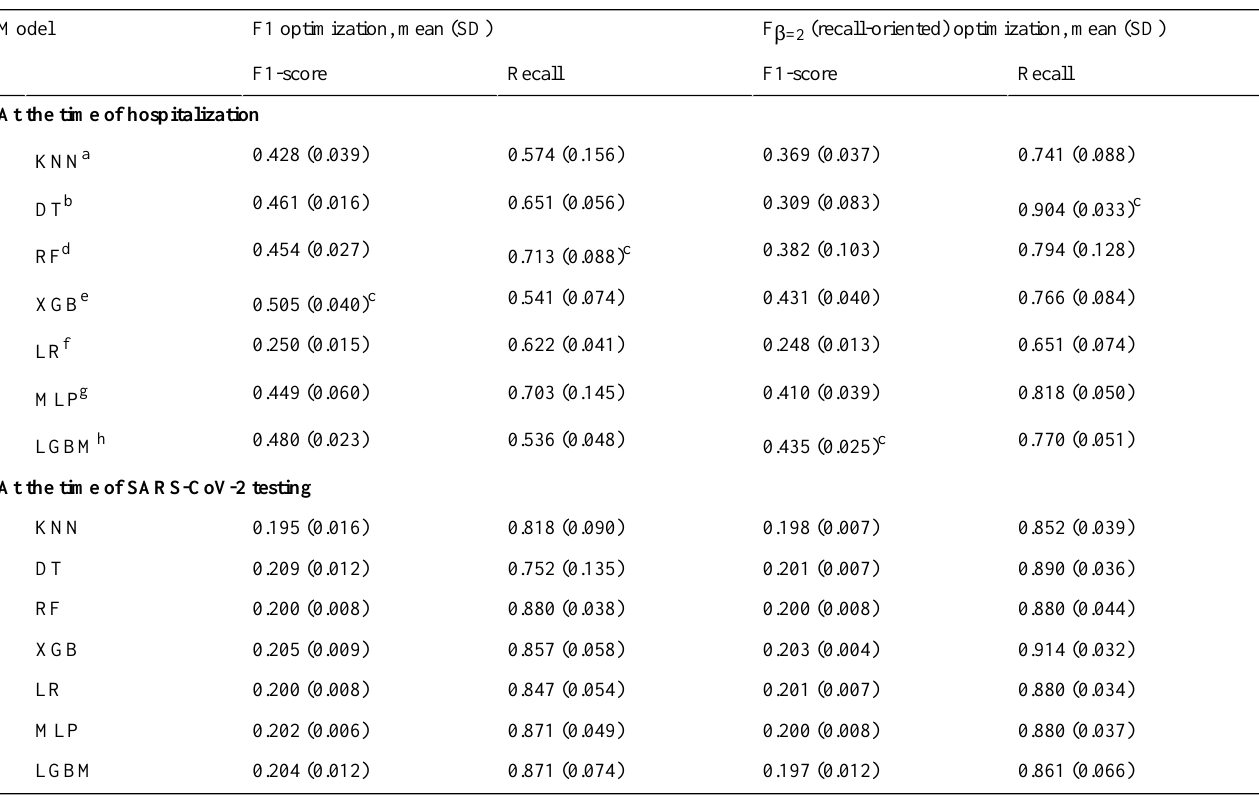
Table 3. Predictability of intensive care unit admissions per predictive